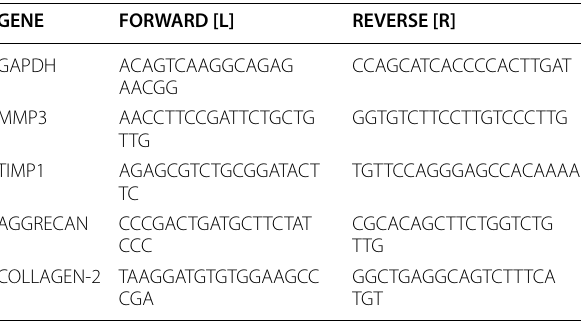
Table 2 QPCR Primer Sets for Bovine